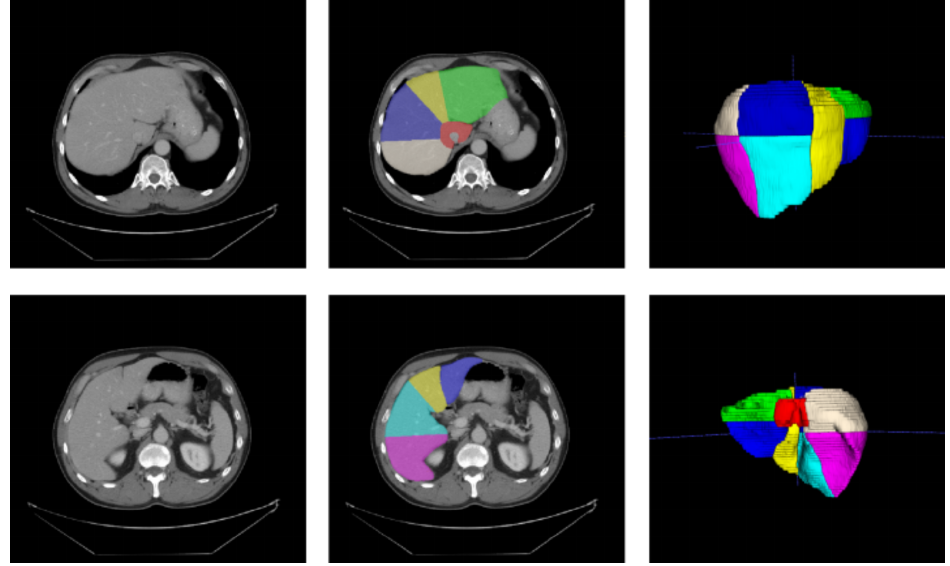
Figure 1. Medical Segmentation Decathlon Task 08 [57], with annotations from Tian et al. [21]. Left: original slices; middle: slices with segments’ annotations; right: meshes’ reconstructions of